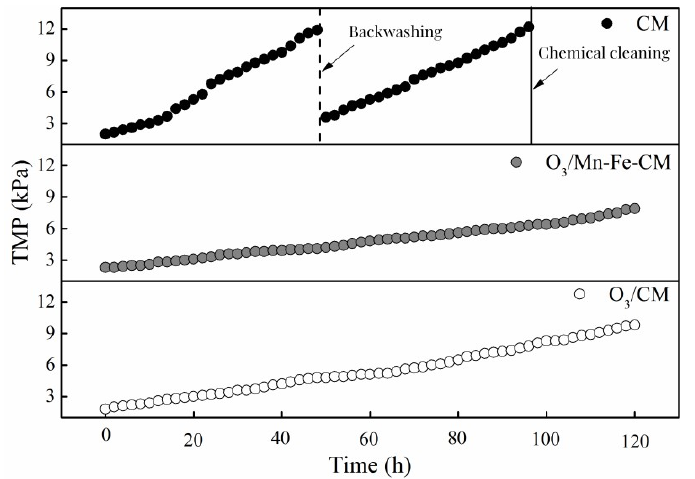
Figure 5. Variation in transmembrane pressure in Pretreatment/CM, and Pretreatment/O 3 /CM, and Pretreatment/O 3 /Mn-Fe-CM in combined process.